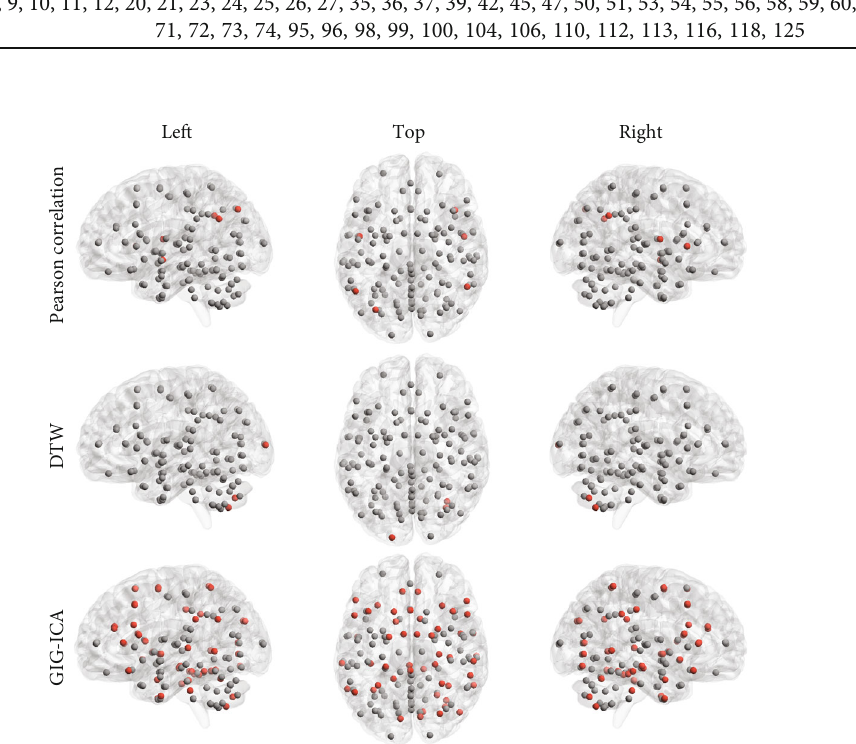
Figure 5: Distribution of the brain parcels (red dots) that exhibit signi fi cant groupwise di ff erences over HC, MCI, and AD stages, in terms of nodal clustering coe ffi cient. For the node indexes and names, refer to Tables 2 and